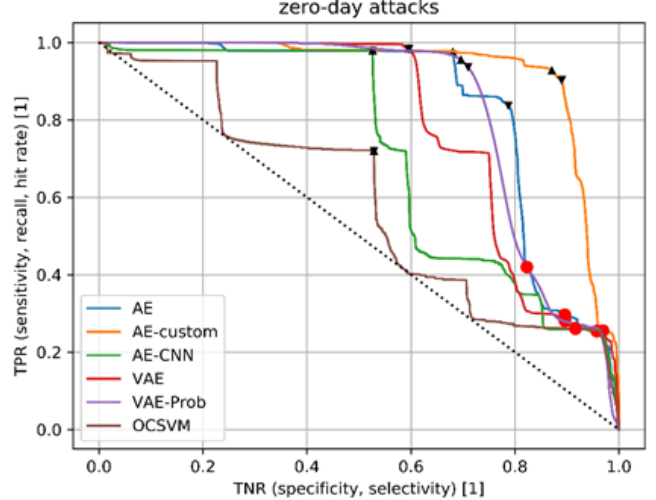
Figure 7. ROC curves for the detection of unknown zero-day